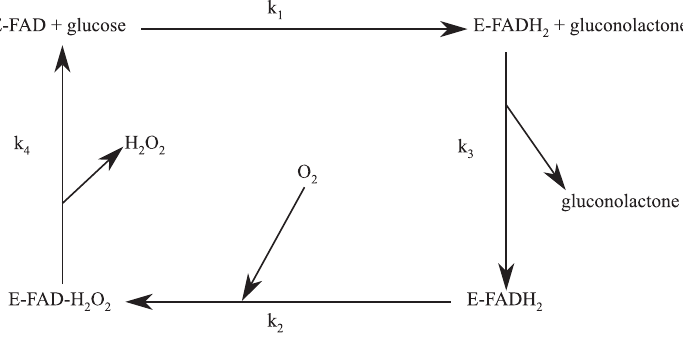
is the oxygen concentration in the bulk 2